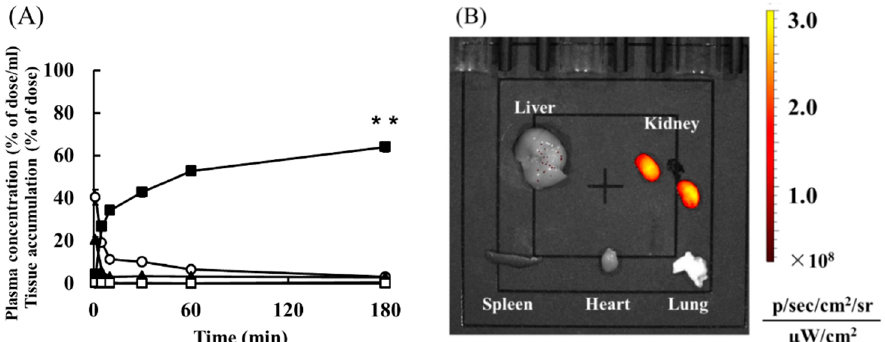
Figure 2. ( A ) Time courses of plasma concentration and tissue accumulation after intravenous administration of 1 mg kg − 1 of 111 In-labeled Ser-PAMAM-Cys. Results are expressed as means ± SE for three mice. ○ , plasma; ▲ , liver; ■ , kidney; ◊ , spleen; △ , heart; □ , lung. ( B ) Ex vivo imaging of NIR- labeled Ser-PAMAM-Cys 60 min after intravenous injection. Fluorescence intensities were determined for the liver, kidney, spleen, heart, and lung. ** p < 0.01, significantly different from other tissues.